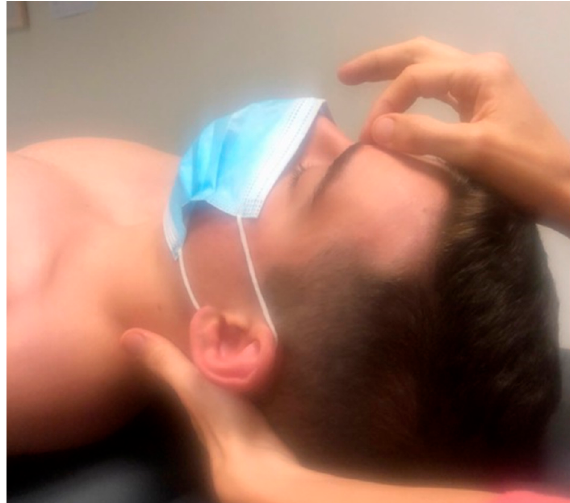
Figure 1. Checking 1st fuse: Inn-trann.